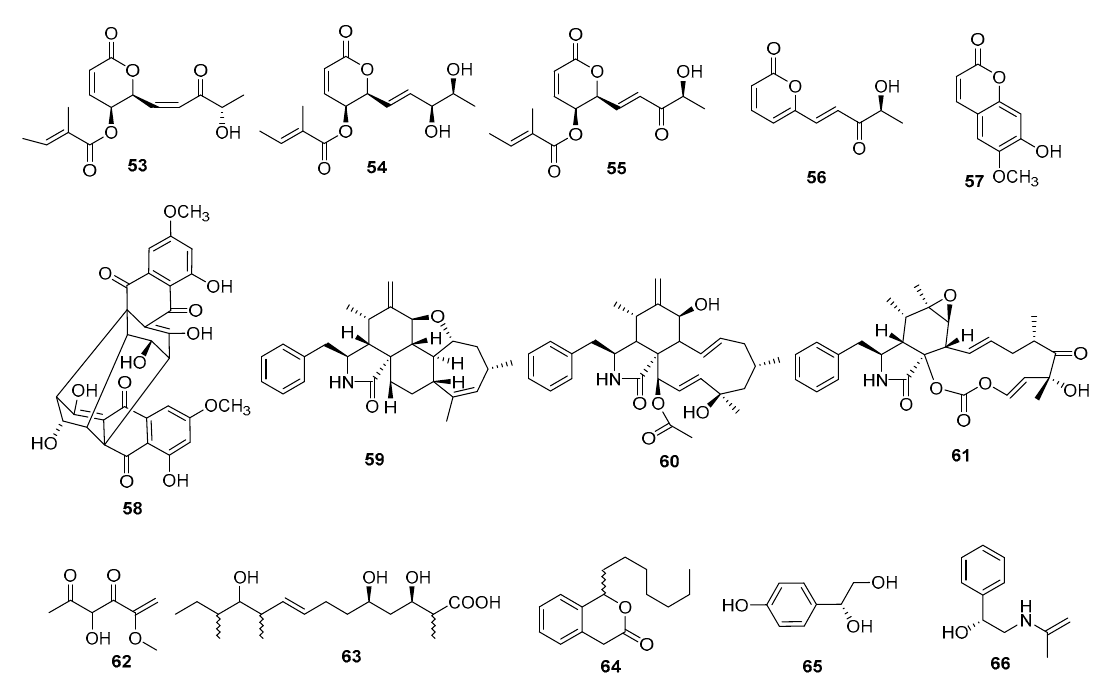
Figure 3. Chemical structures of compounds 53 – 66 of terrestrial origin.